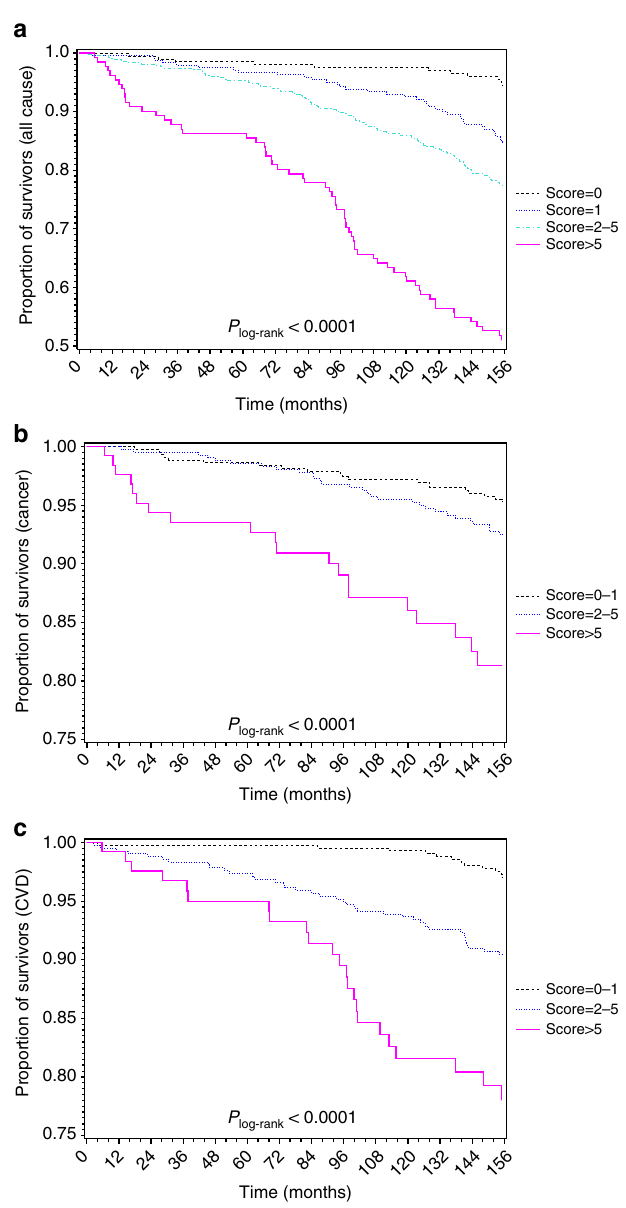
Figure 3 | Kaplan–Meier estimates of survival by risk score in the ESTHER study ( N ¼ 1,000). ( a ) Survival curves with respect to death from any causes; ( b ) survival curves with respect to death from cancer; ( c ) survival curves with respect to death from CVD. P log-rank was derived from log-rank